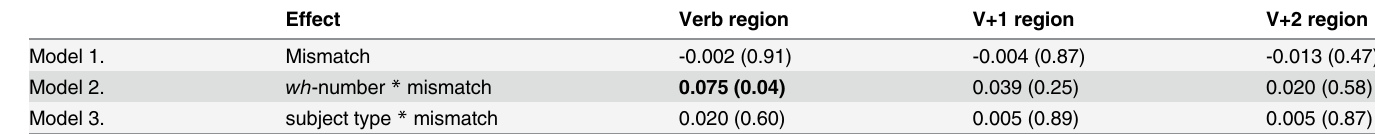
Table 4. Estimates and (p-values) for agreement attraction models. Bold font indicates a signi fi cant